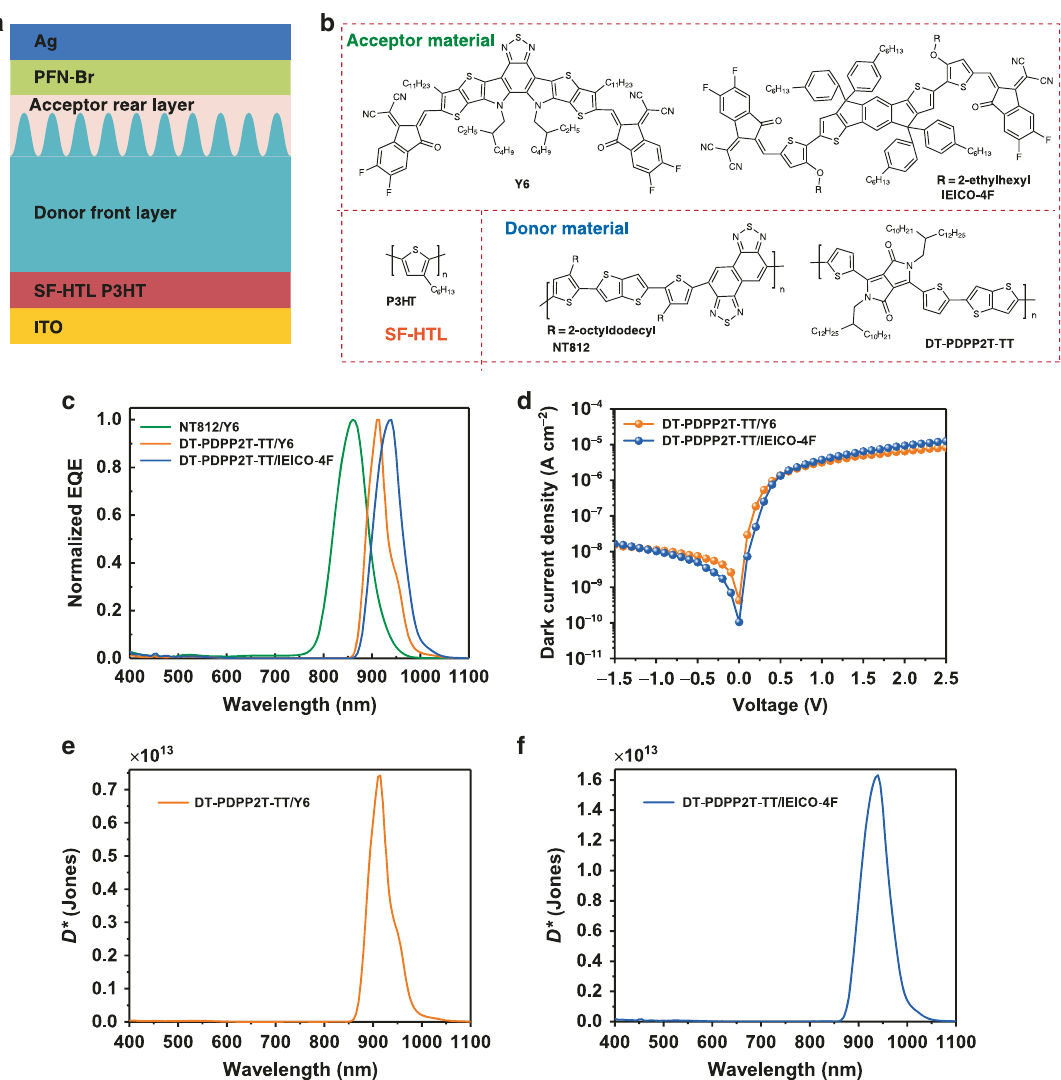
Fig. 4 Universality of the SF-narrowband OPD. a Typical device structure of self- fi ltering (SF) narrowband organic photodetector (OPD) with double donor layers. b Chemical structures of the selected donor materials, acceptor materials and SF hole transport layer (SF-HTL) materials. c